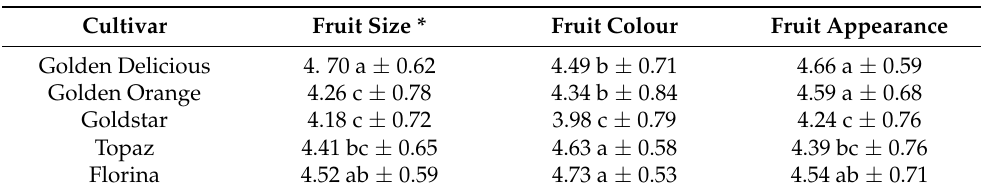
Table 2. Consumer evaluation of the fruit of five apple cultivars for external quality attributes—size, skin colour and shape (mean ± standard